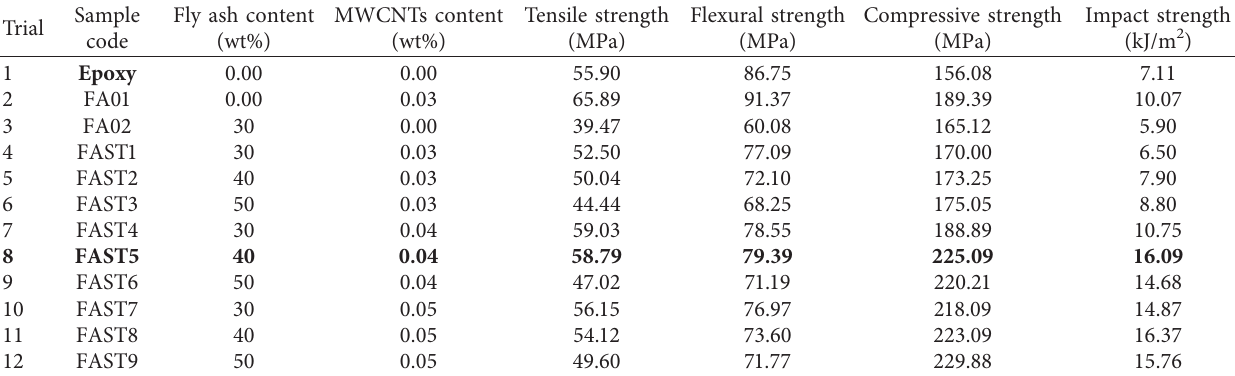
Table 3: Optimum mechanical properties of epoxy/fly ash/MWNT nanocomposites from fine tuning experiments. Sample Trial